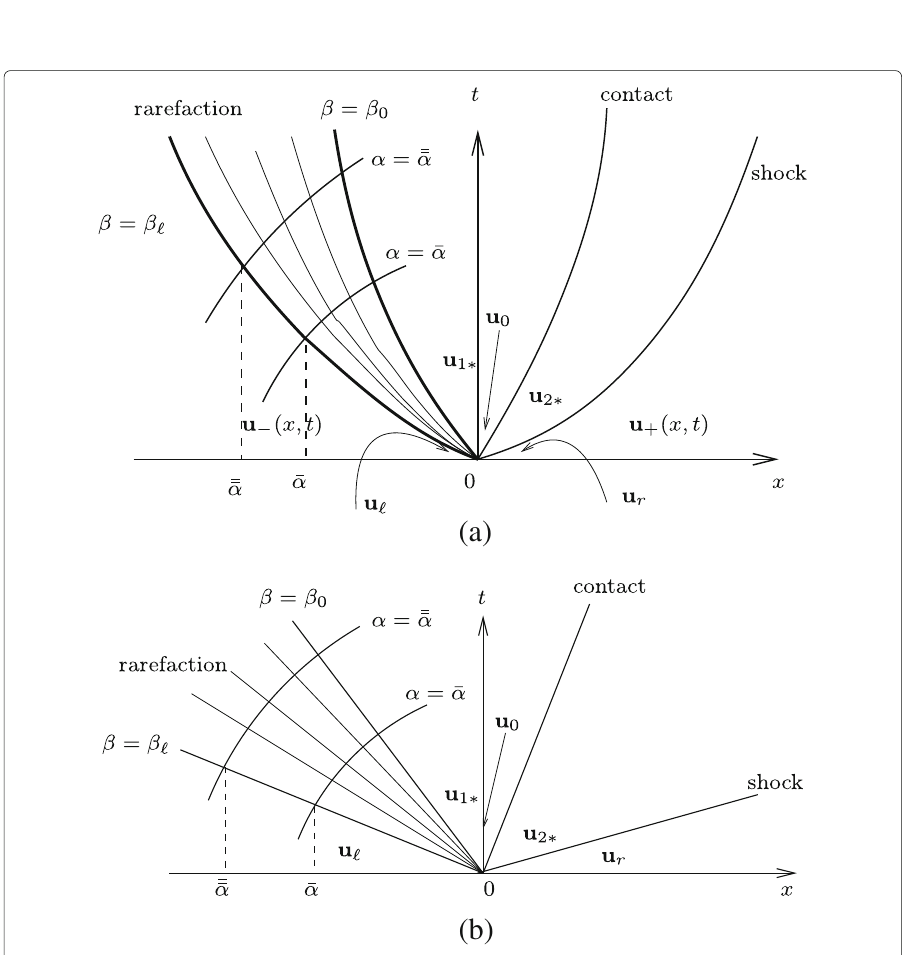
Fig. 3 Typical wave pattern for the generalized Riemann problem. a Wave pattern for the GRP. The initial data u ( x ,0 ) = u (cid:7) + x u (cid:3) (cid:7) for x < 0 and u ( x ,0 ) = u r + u (cid:3) r x for x > 0. b Wave pattern for the